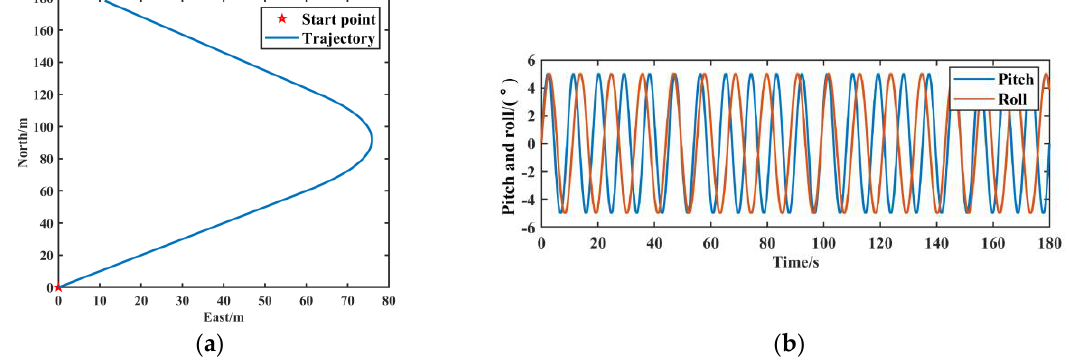
Figure 6. ( a ) Motion trajectory of the simulation experiment boat; ( b ) pitch and roll.